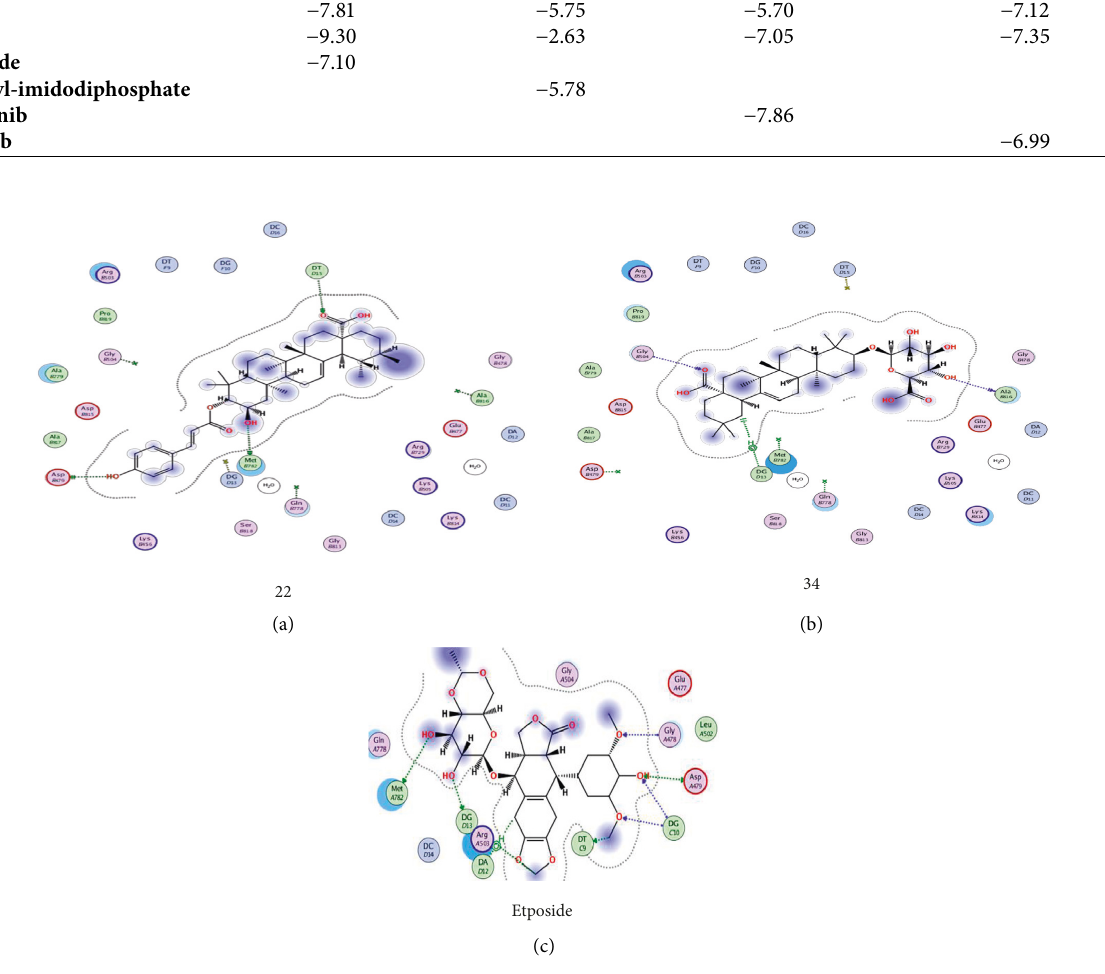
Table 3: Affinity binding docking scores (Kcal/Mole) of bioactive isolated compounds. Compound no.